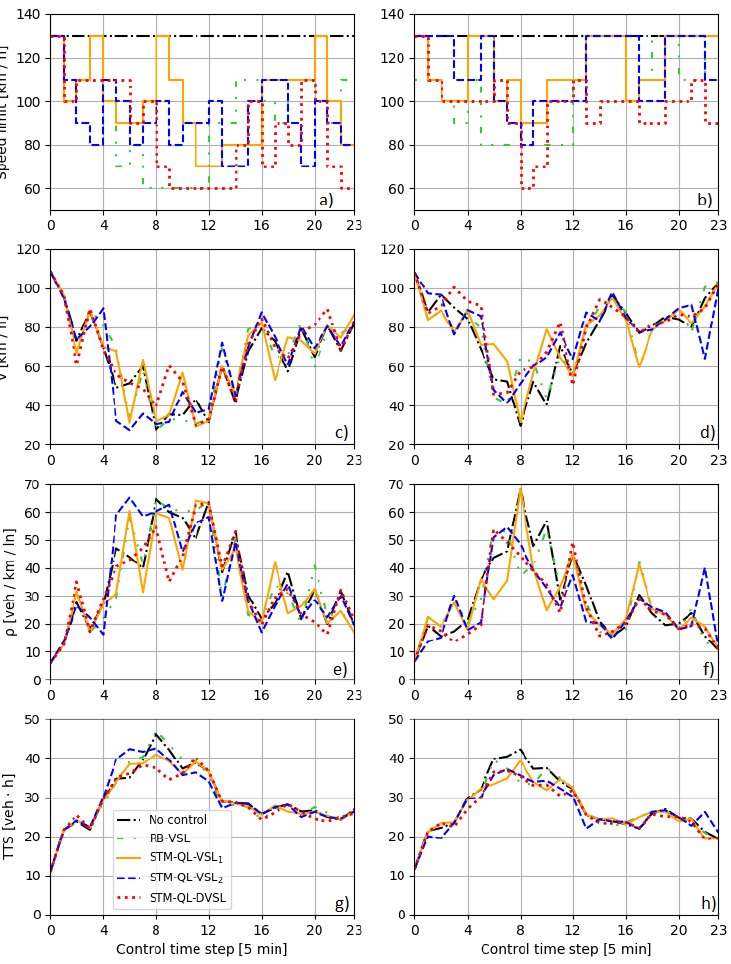
Figure 5. Obtained speed limits, speeds, densities, and TTS for scenario 1 ( a , c , e , g ) and scenario 2 ( b , d , f , h